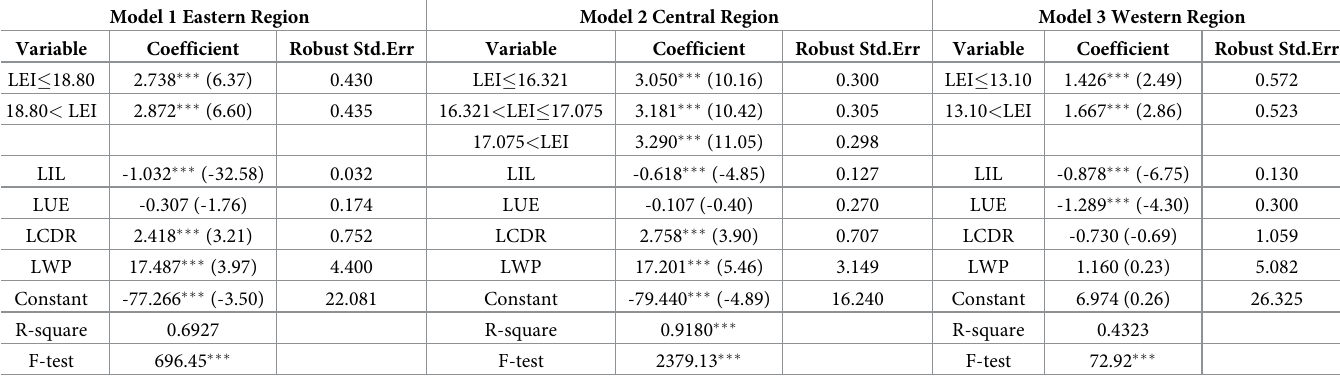
Table 16. Threshold regression estimation.